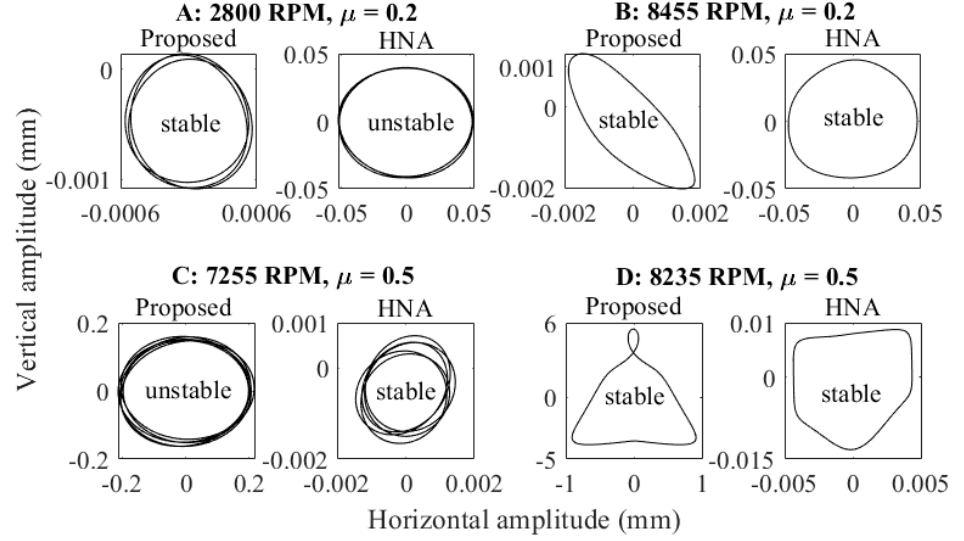
Figure 16. Orbital trajectories of Node 1 for rotor speeds relating to points of interest ( A – D ) as predicted by the proposed model and the chosen horizontal neutral axis model. The solution used six harmonic terms.